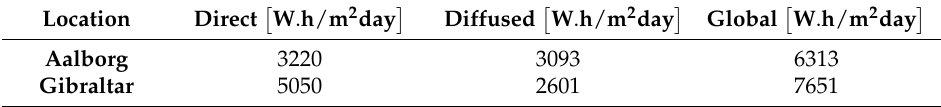
Table 3. Yearly average of direct, diffused, and global irradiance in Aalborg and Gibraltar.